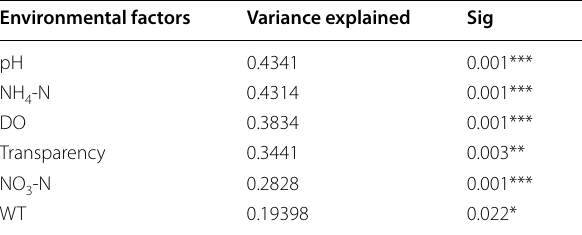
Significance levels with *, **, and *** represent p-value < 0.05, 0.01, and 0.001 between groups, respectively (permutation test)